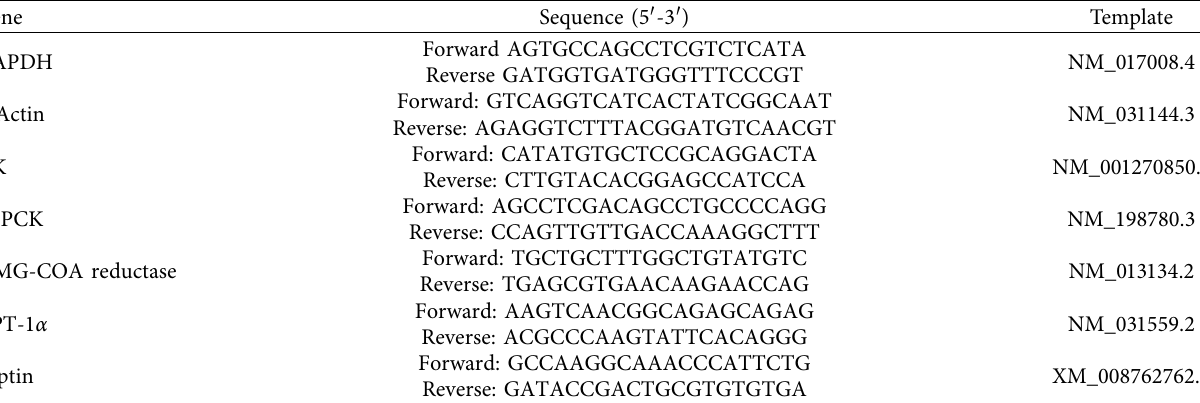
Table 2: Sequences of gene-specific